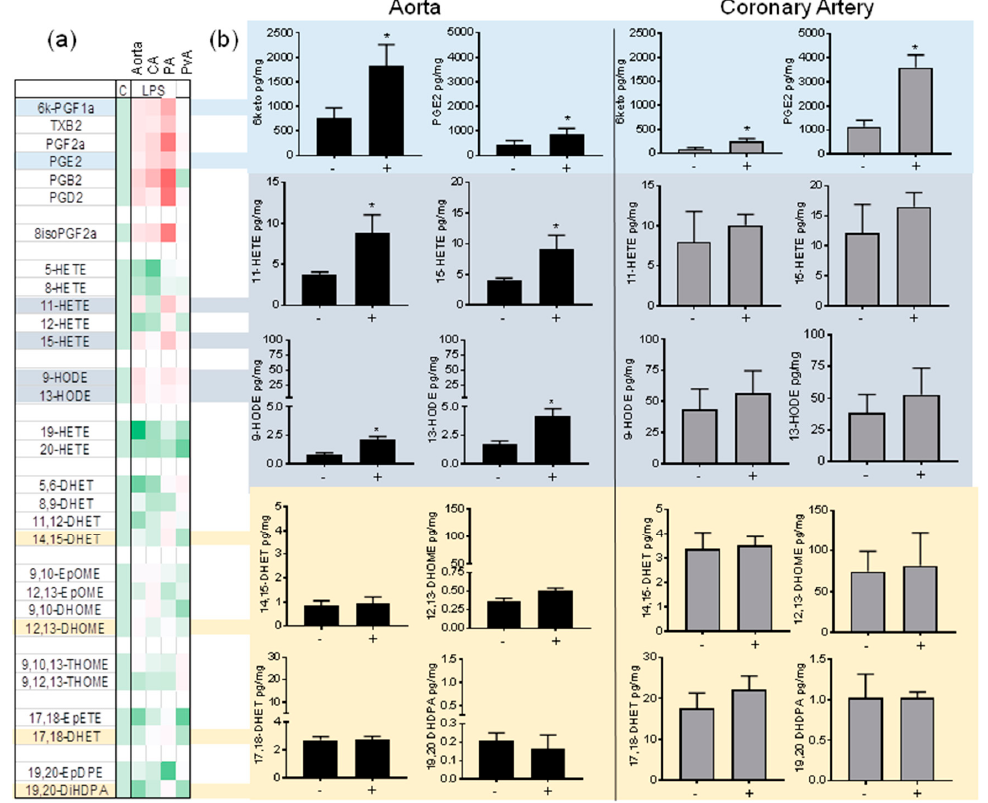
Figure 4. Regulation of oxylipin production in large vessels by LPS/TLR4 activation. ( a ) Heatmap showing summary of fold differences in the mean oxylipin generation in aorta, coronary artery (CA), pulmonary artery (PA) and perivascular adipose (PvA) untreated tissue (C) compared to tissue treated with LPS (1 μ g/mL) ex vivo. The range of fold differences was from 0.5- (19-HETE; Aorta) to 9-fold (PGB 2 ; PVA). ( b ) Comparison of major oxylipin production: 6-ketoPGF 1 α , PGE 2 , 11-HETE, 15- HETE, 9-HODE, 13-HODE, 14,15-DHET, 12,13-DHOME, 17,18-DHET and 19,20-DHDPA in aorta and coronary artery treated in the absence (-) or presence regulation by LPS (1 μ g/mL; +). * indicates p < 0.05 by unpaired t -test between tissue treated in the presence of absence of LPS. Data represents organ culture from n = 3–4 separate animals. 3.3. The sEH Inhibitor TPPU Reduces TLR-4 Induced Inflammation in pCASMCs LPS did not induce the pig CYP2J homologue CYP2J34 in organ culture tissue (pulmonary artery and coronary artery) at 24 h or in primary pCASMCs (Figure 5a) at 4 h. By contrast, LPS strongly induced TNF α mRNA in both organ culture tissue and pCASMCs (Figure 5a). Although not induced by LPS, the endogenously produced EpFAs were anti-inflammatory in pCASMCs, as co-treatment of pCASMCs with the sEH-I TPPU (1 uM) significantly reduced LPS-induced TNF α , ICAM-1 , VCAM-1 , MCP-1 ( CCL2 ), and CD40 mRNA (Figure 5b).